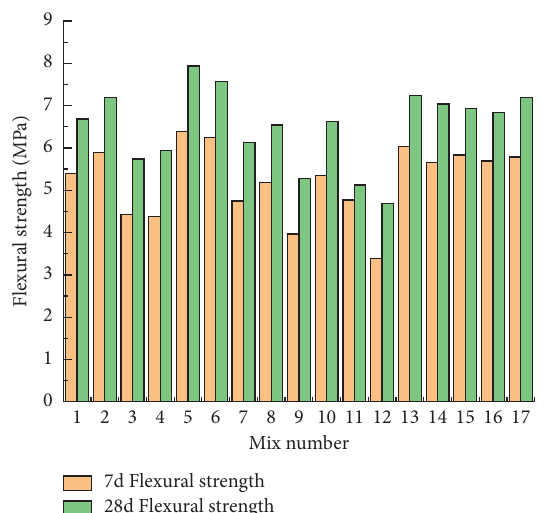
Figure 8: Flexural-compressive ratio of different fit ratios and